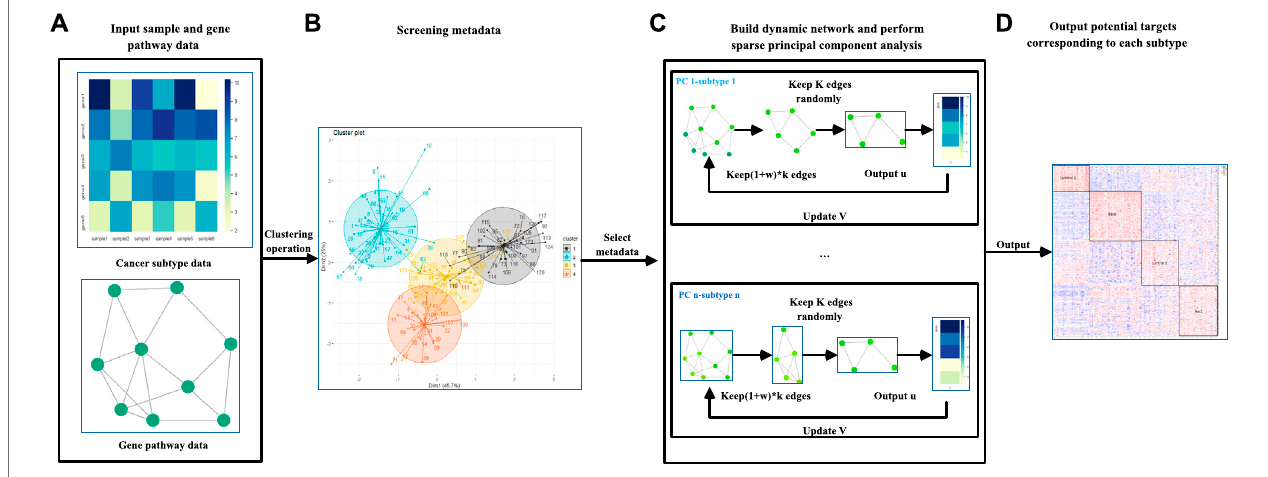
FIGURE1| FlowchartoftheDM-ESPCA model. (A) TheDM-ESPCA model requiresinputgeneexpression and pathway data. (B) TheDM-ESPCA model selects meta-data by clustering all samples. (C) Work fl ow ofthe DM-ESPCA model to screen targeted genes. The DM-ESPCA model will generate a dynamic gene network for each subtype. (D) Finally, this model will output the screened genes.